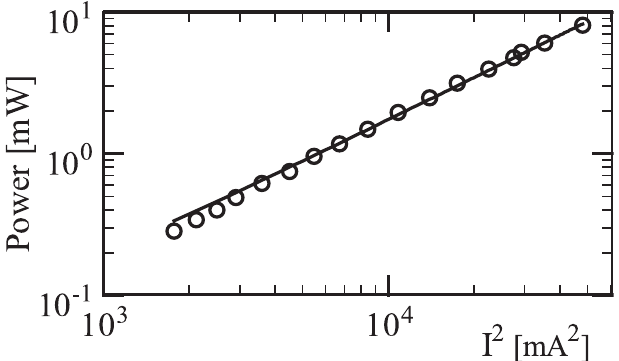
FIG. 3. CTR power measured by the diode as a function of the pulse current squared. The solid line is a linear fit to the data